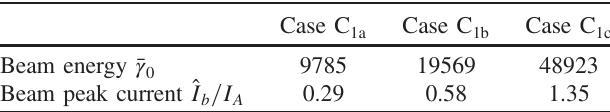
1 a (blue), for a (green) and for a beam b (red), obtained from PIC c b